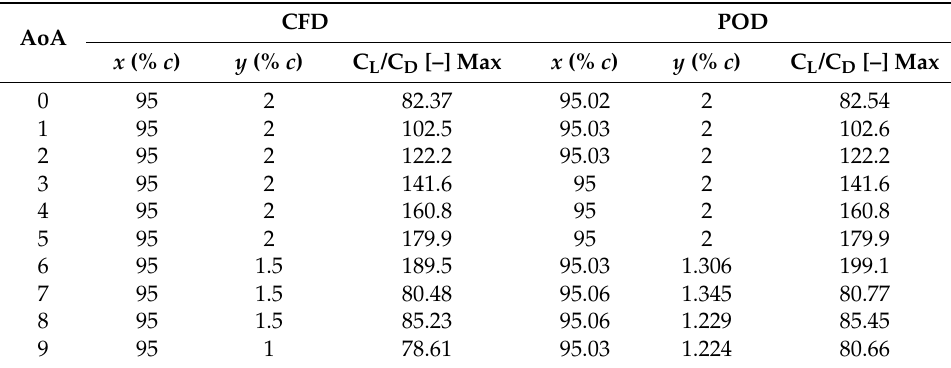
Table 5. Results of the CFD and POD calculations for each AoA of the airfoil which achieved the maximum value of C L /C D with